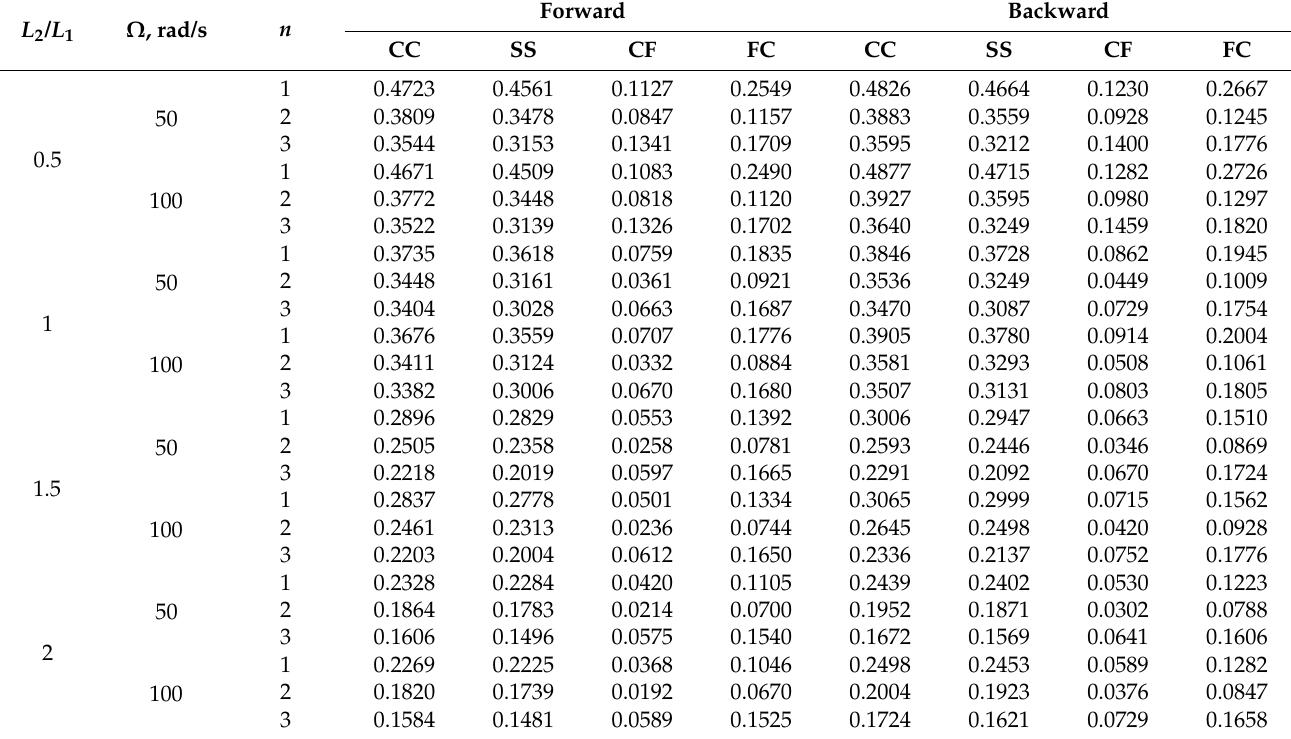
Table 5. Dimensionless frequencies of rotating laminated combined conical-cylindrical shell